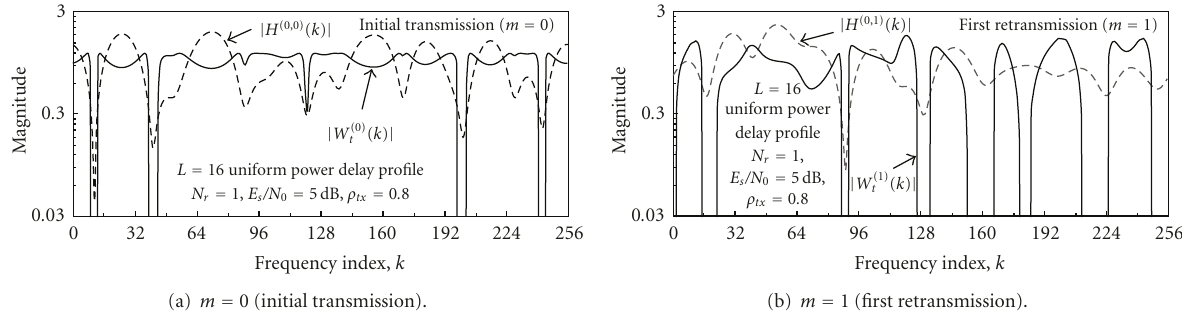
Figure 3: Channel transfer function and Tx MMSE-FDE weight for channel case 1.